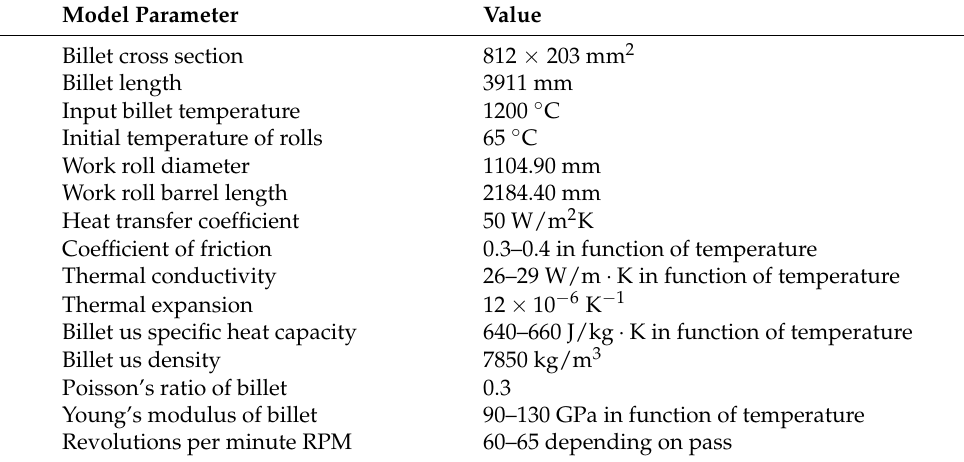
Table 1. Input parameters used for the three-dimensional FEM